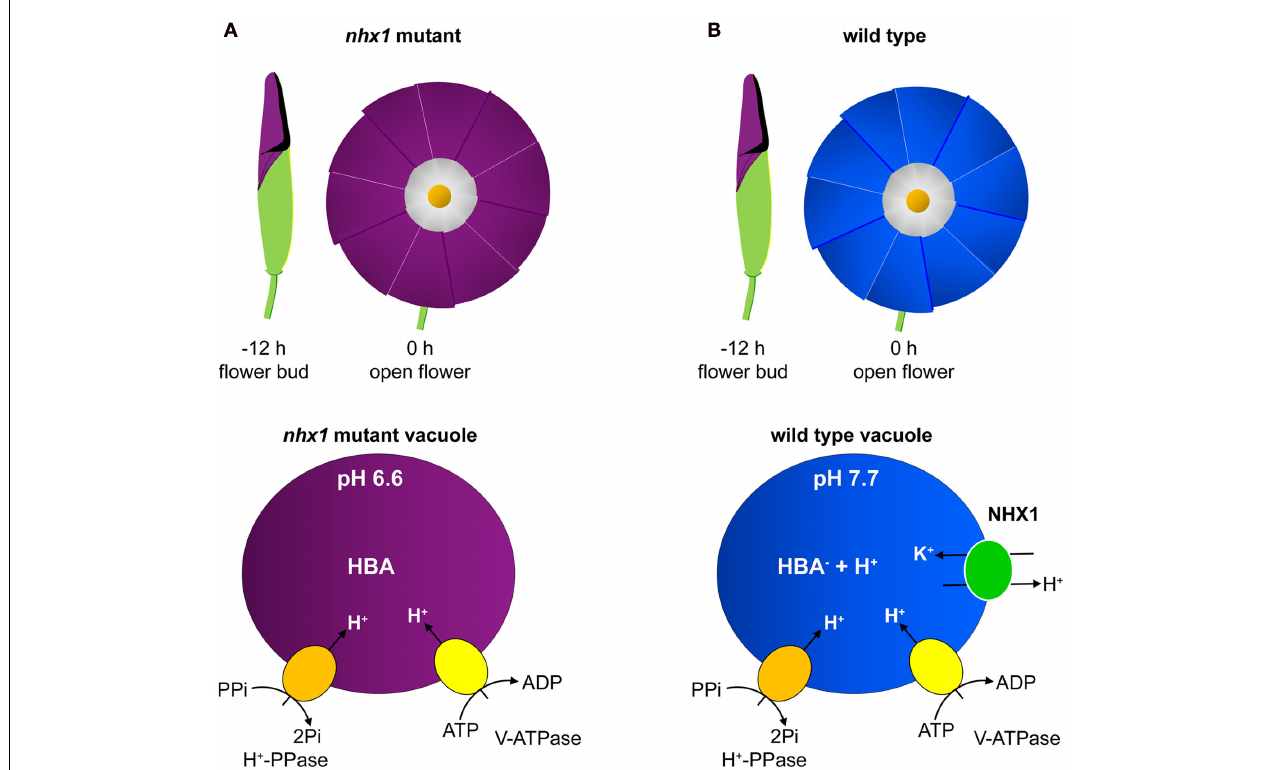
alkalinization of the vacuolar lumen causing a change in the ionic form of the pigment HBA.When NHX1 is deleted (A) the color change does not occur when the flowers open as the lack of NHX1-dependent K + /H + exchange activity means that the acidification of the vacuolar lumen by the H + pumps is not reduced. Figure adapted fromYoshida et al.